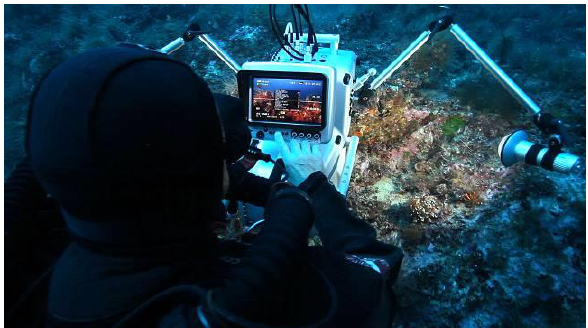
Figure 3. First tests at sea. At over 60 meters deep in Mediterranean, the operator is working on the 3D assist monitor: this is fundamental to achieve a good stereography.